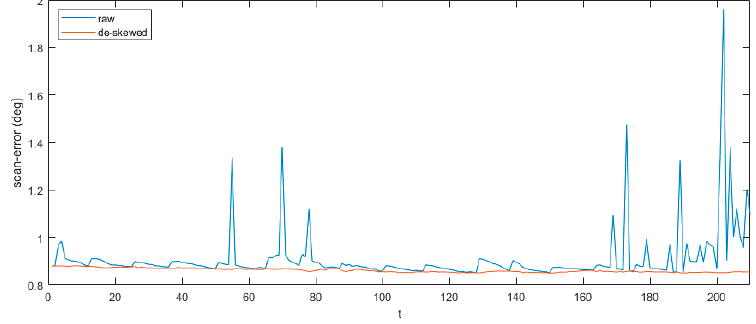
Figure 13. Cloud before and after de-skewing. The left part was the top view of our room. The above part on the right side of this figure represents the point cloud before de-skewing and the below part after de-skewing.